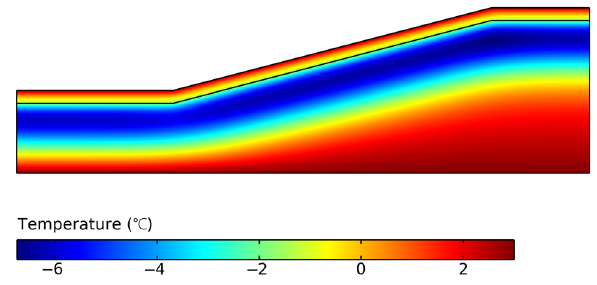
Figure 5. Temperature distributions of the canal at 97 h.